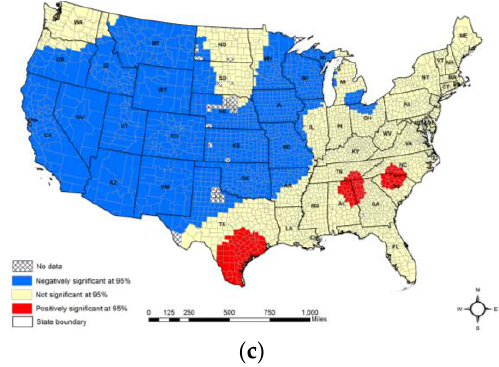
Figure 6. Significance map of the GWR model; ( a ) mean county altitude; ( b ) percentage of the African American population; and ( c ) the association rate.